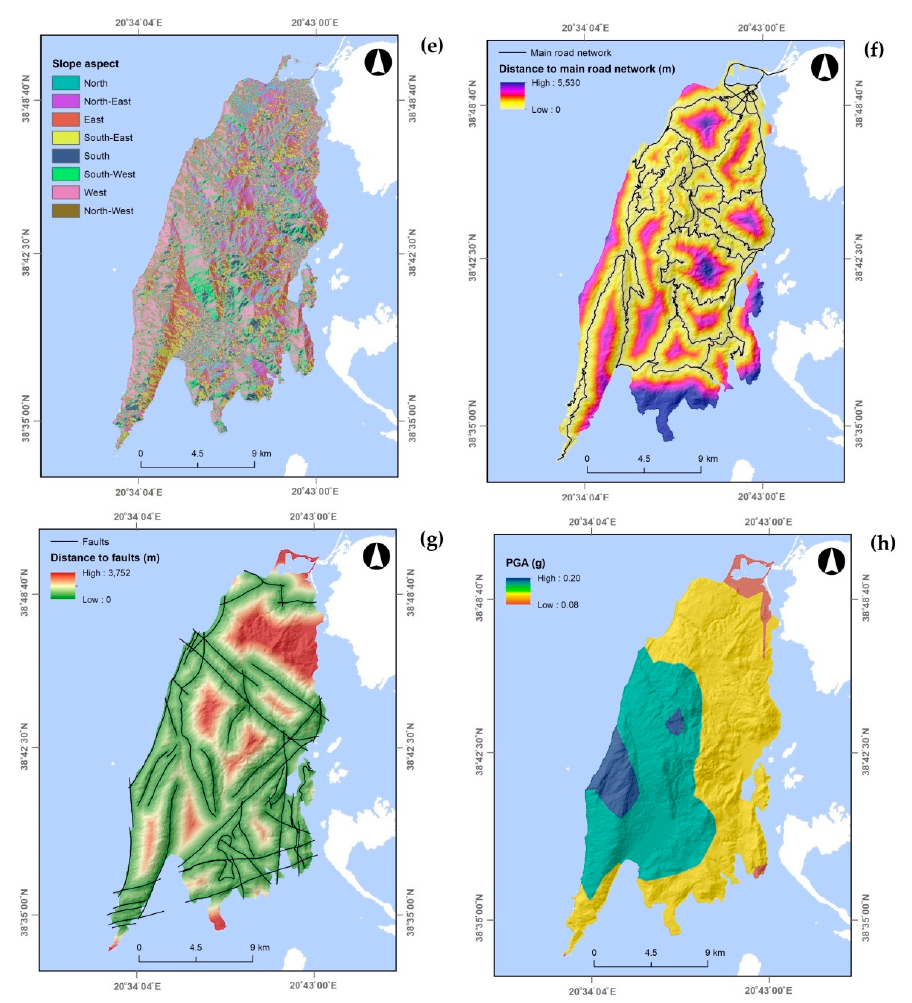
Figure 2. Geo-Environmental factors: ( a ) Land cover; ( b ) lithology; ( c ) elevation; ( d ) slope angle; ( e ) slope aspect; ( f ) distance to main road network; ( g ) distance to faults; ( h ) peak ground acceleration (PGA).